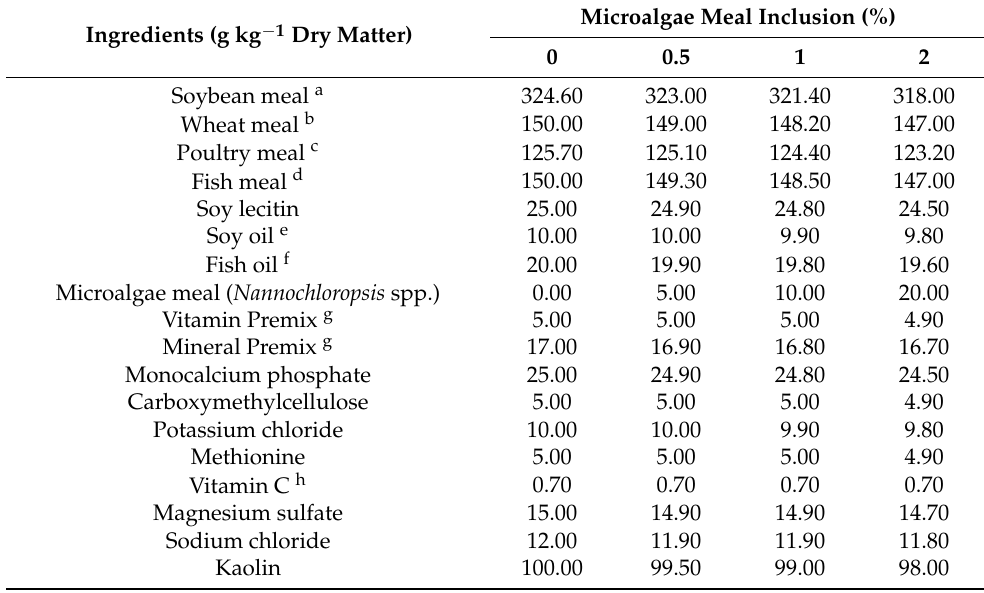
Table 3. Formulation and composition of the experimental diets for Litopenaeus vannamei containing microalgae ( Nannochlorosis spp.) meal at different